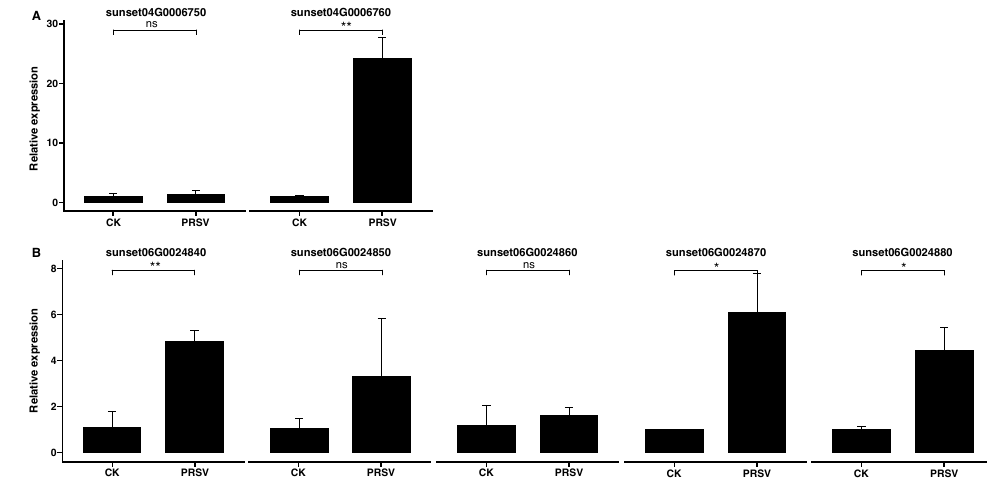
Figure 8. Real-time quantitative PCR analysis of NLR genes in PRSV infected papaya. ( A ) Relative expression levels of RNL duplication gene pairs. ( B ) Relative expression levels of CNL duplication gene pairs. Error bars indicate the standard deviation. Statistical significance is evaluated by T-test and represented by symbols (ns: p > 0.05, *: p < = 0.05, and **: p < =